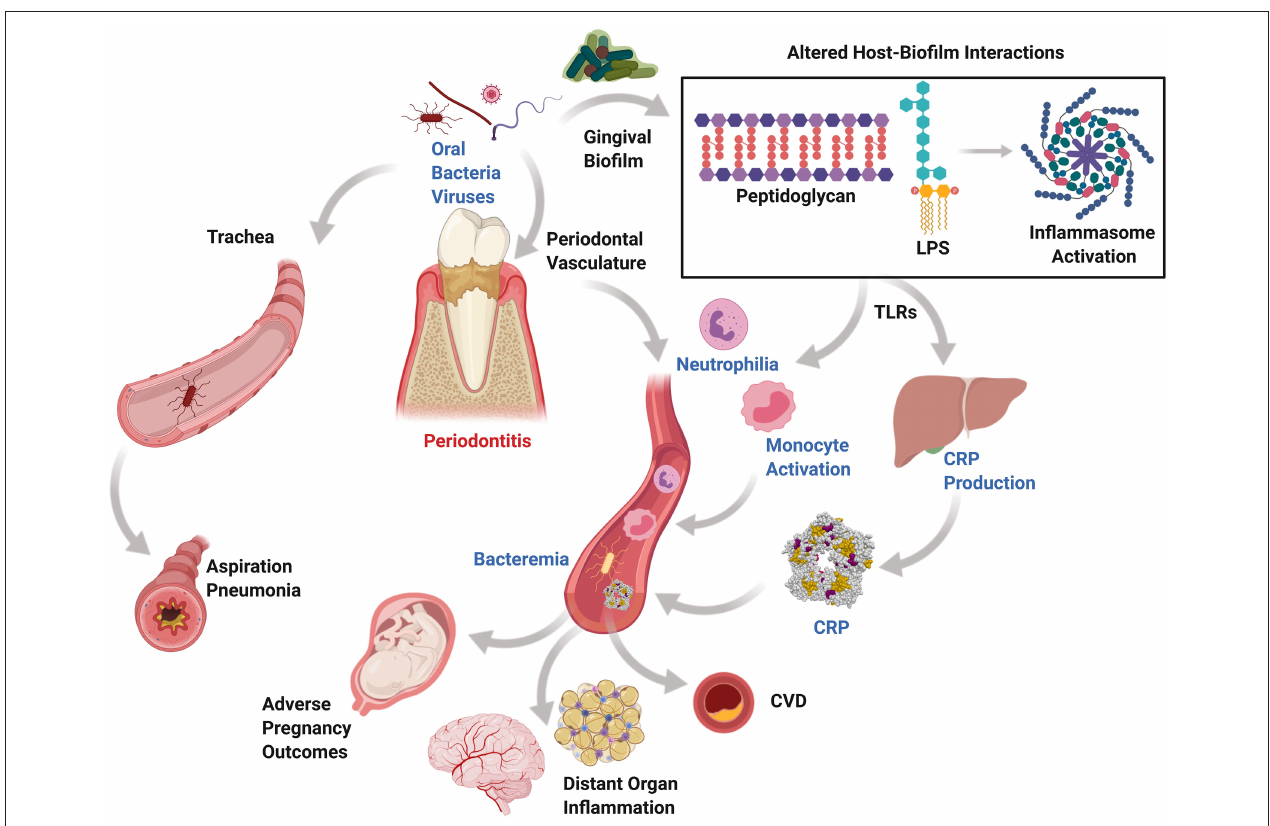
FIGURE 1 | Mechanisms of periodontal systemic connections. Periodontitis, a chronic inflammatory condition affecting tooth-supporting structures and resulting from altered host-biofilm interactions, generates periodontal pockets that harbor oral anaerobic bacteria and viruses. These can be released systemically through the highly vascularized pocket granulation tissue or through aspiration via the oropharynx in those at risk and during therapeutic interventions. Circulatory release of proinflammatory cytokines, bacteria, and their byproducts may be associated with bacteremia, circulating leukocyte priming, low-grade inflammation, and ectopic deposition in distant organs. Similarly, aspirated anaerobic bacteria can colonize the lungs and lead to aspiration